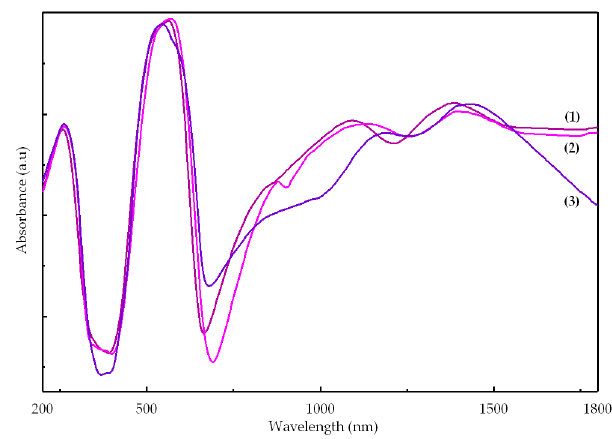
Figure 5. UV-Vis-NIR spectra of complexes.